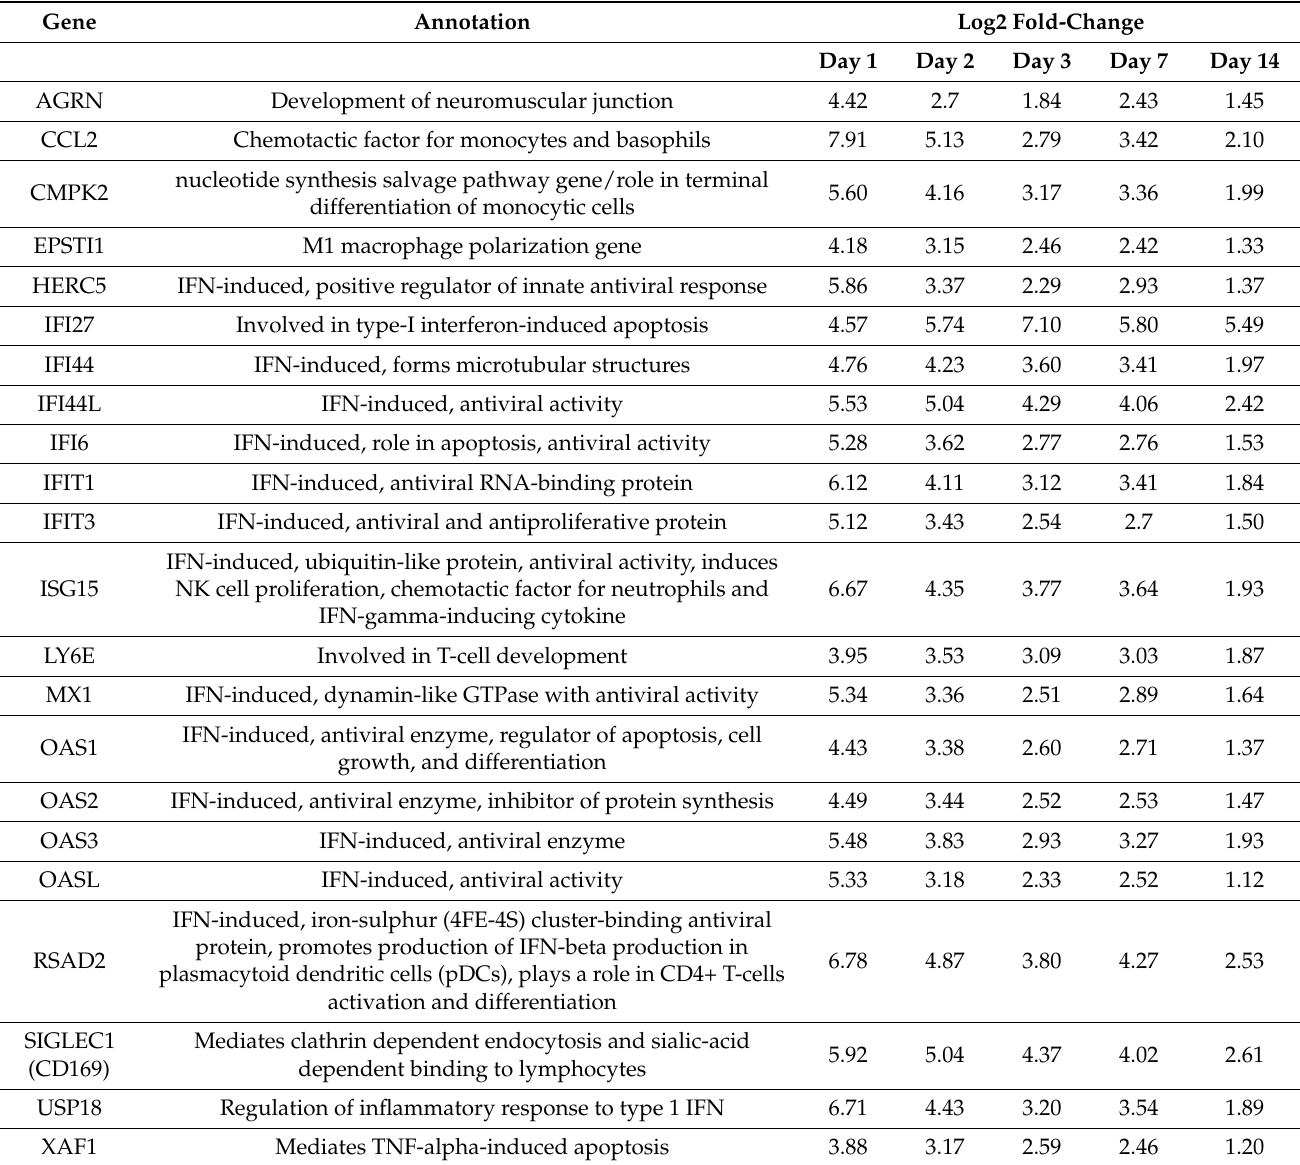
Table 1. Log 2 fold-change values of the 22 genes differentially expressed from day 1 through day 14. Gene